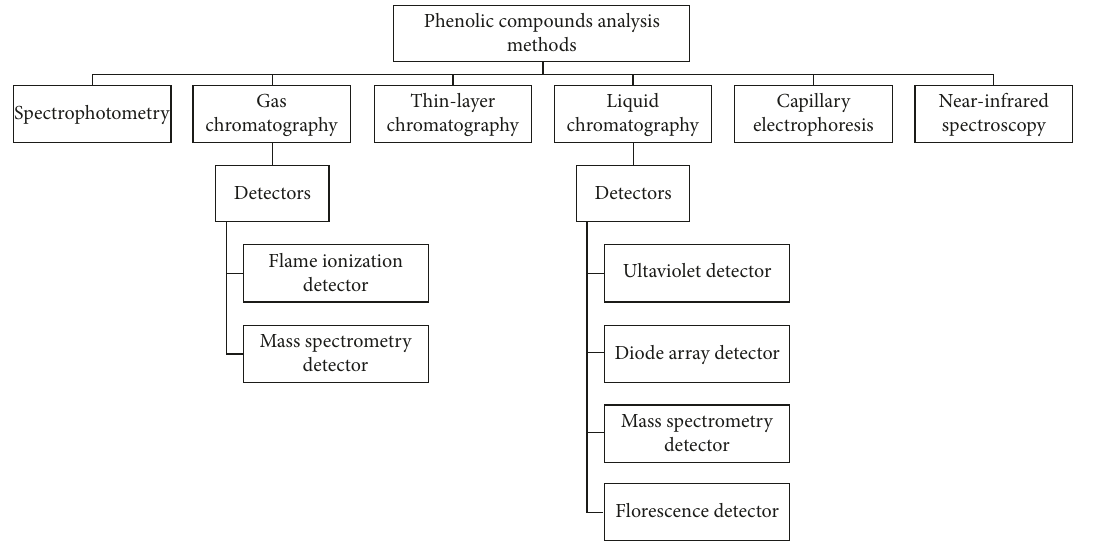
Figure 1: Methods used for both qualitative and quantitative analysis of phenolics